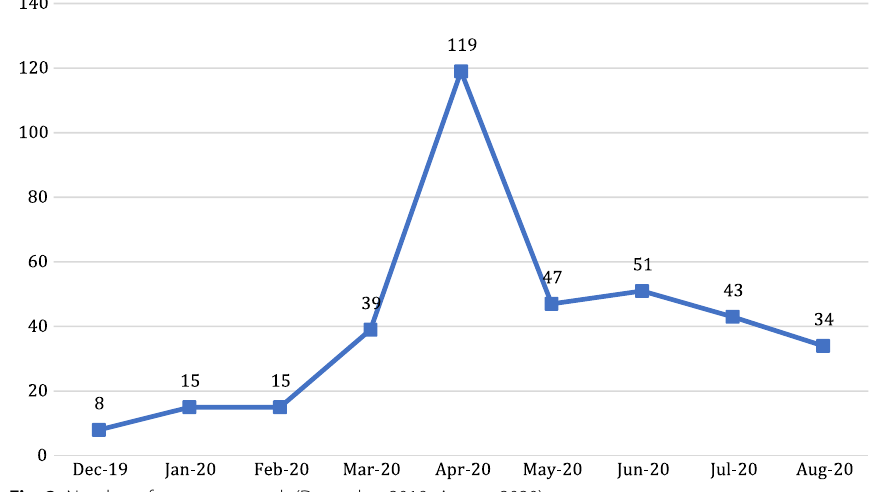
Table 2 Categorisation of posts about sharing information and resources (n